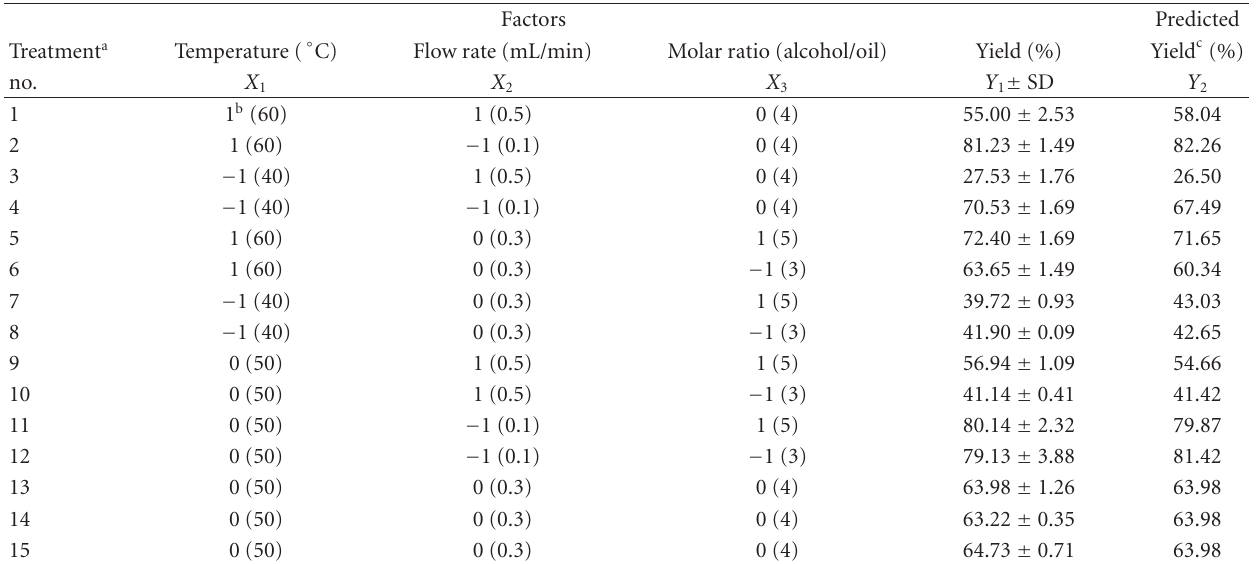
Table 1: 3-level-3-factor Box-Behnken design of experiments.